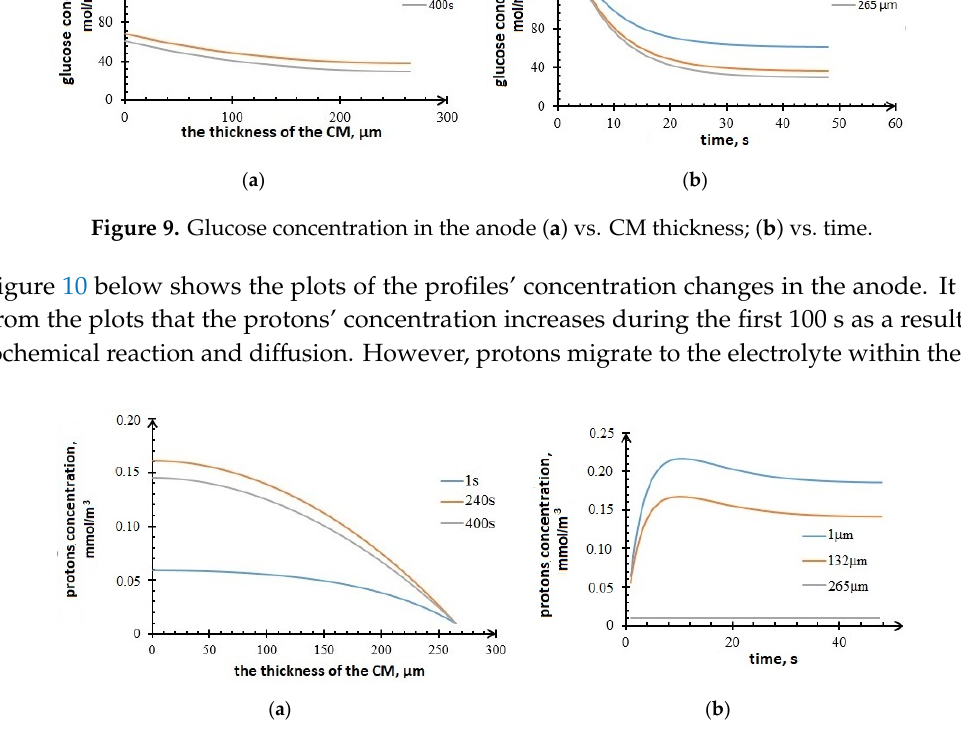
Figure 8. Current–voltage potentiodynamic curves and dependences of power density on current density for MFC CoFe/CNT + BM.